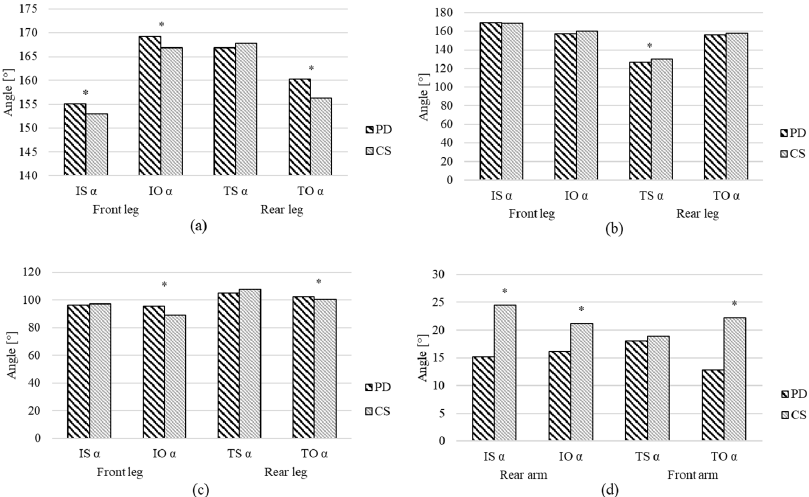
Figure 3. Hip ( a ), knee ( b ), ankle ( c ), and shoulder ( d ) joint α in PD and CS during double support phase (DSP). Leg during gait cycle turns from IS into TO and from IO into TS. Arms fluently change from IS into TO (rear arm) and from IO into TS (front arm). Parameters with a statistically significant difference between PD and CS are marked with an asterisk (*).